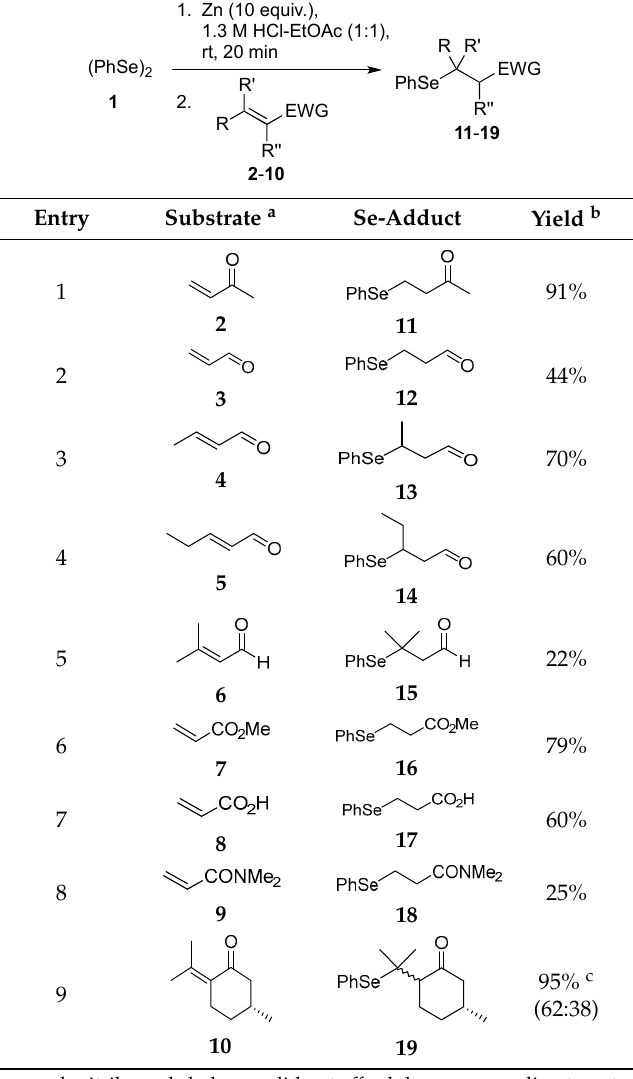
Table 1. Telescoped diselenide reduction-conjugate addition to α , β -unsaturated carbonyl derivatives 2 – 10 .